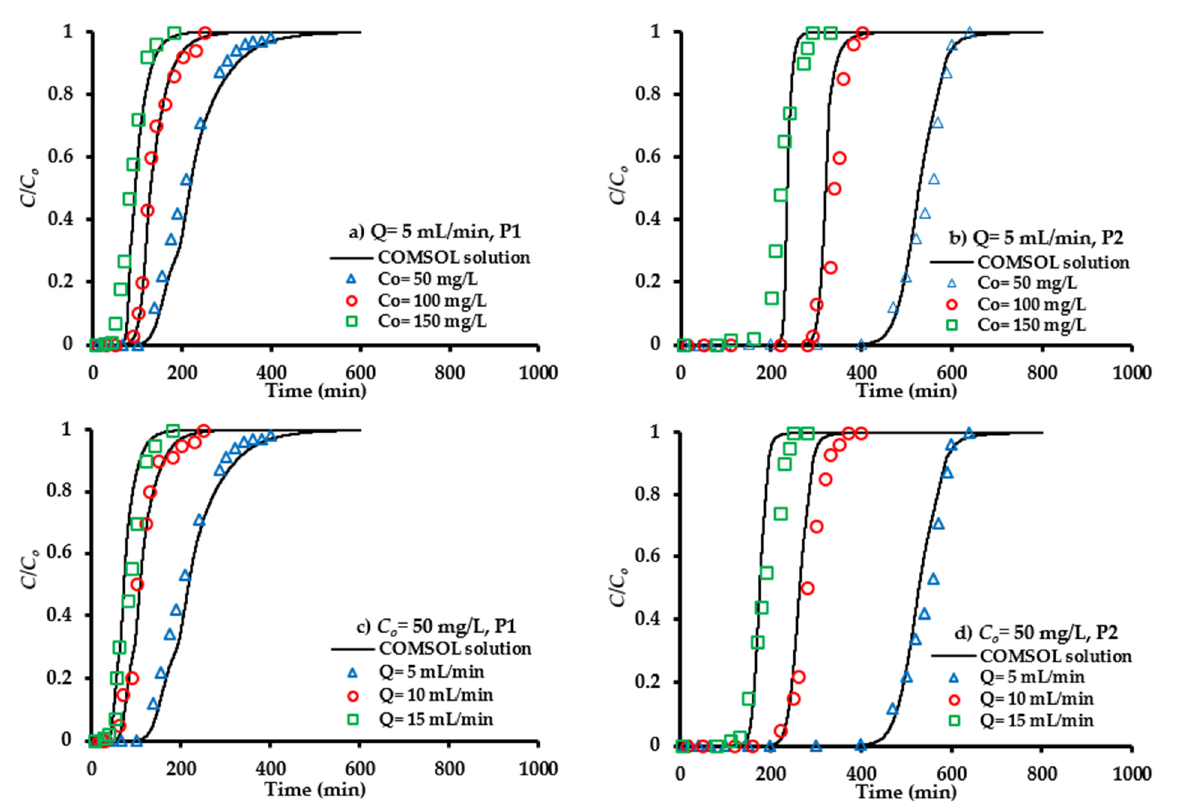
Figure 7. COMSOL outcomes and measurements for the SO 42 − ions normalized concentration at various magnitudes of inlet concentrations ( a , b ) and flow rates ( c , d ) for P1 and P2 ports. Table 3. Values of popular characteristics for real groundwater samples before and after interaction with composited sorbent prepared in this work in column mode operation.